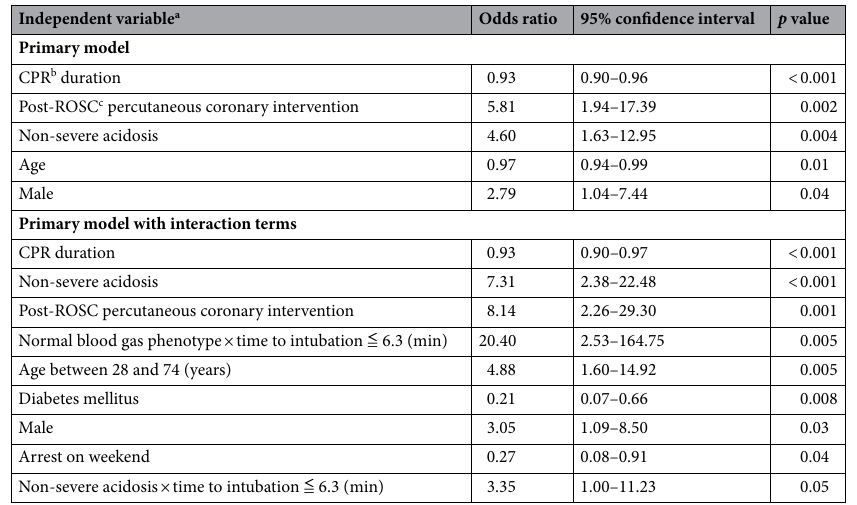
Table 3. Multiple logistic regression model with favourable neurological outcome at hospital discharge as the dependent variable. Primary model: goodness-of-fit assessment: n = 567, adjusted generalized R 2 = 0.32,estimated area under the receiver operating characteristic curve = 0.89, and Hosmer and Lemeshow goodness-of-fit Chi-Squared test p = 0.51; Primary model with interaction terms: goodness-of-fit assessment: n = 567, adjusted generalized R 2 = 0.42, estimated area under the receiver operating characteristic curve = 0.91, and Hosmer and Lemeshow goodness-of-fit Chi-Squared test p = 0.46. a The display of independent variables is arranged in order of p value. b CPR, cardiopulmonary resuscitation. c ROSC, return of spontaneous circulation.